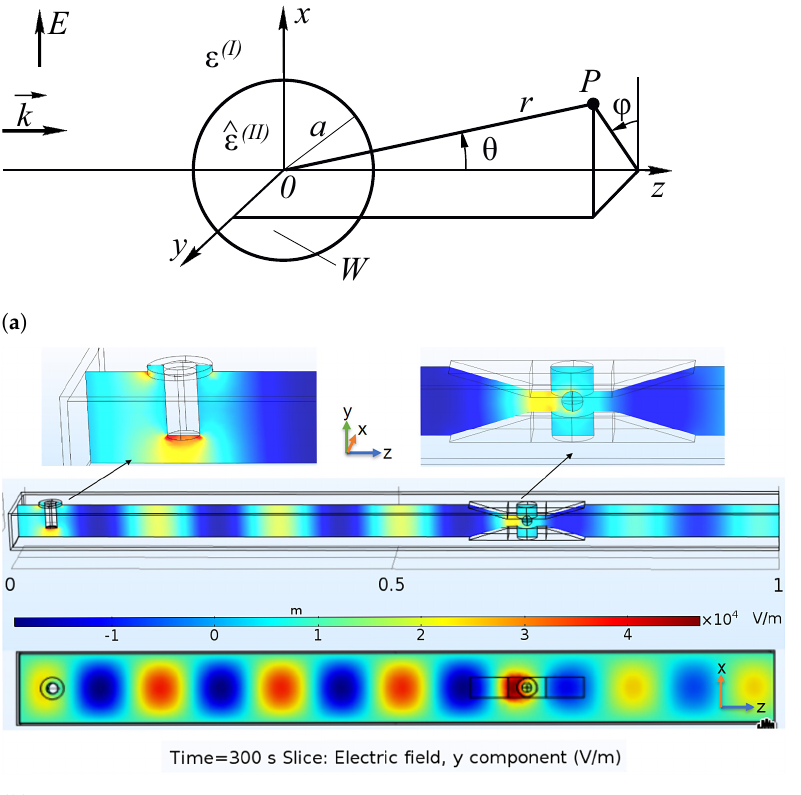
Figure 6. Analytical calculation of the interaction of the plane wave with spherical pellet ( a ) and the finite element simulation of the interaction of the H10-mode wave with spherical pellet in a single-mode rectangular waveguide with H-type inserts ( b ). Here, in the top left is the coaxial cable, which is the source of the wave. In the top right, there is the spherical pellet, located between the H-type inserts in the waveguide to amplify the field strength and